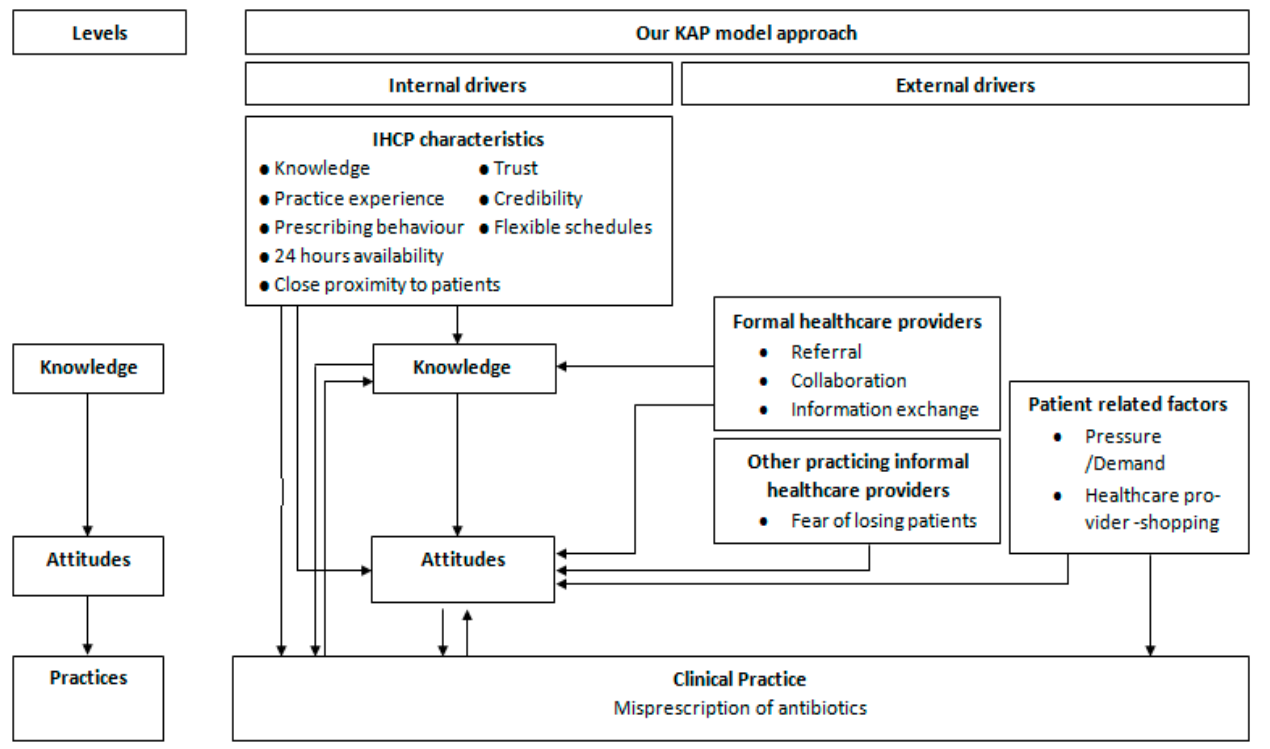
Figure 1. Overview of internal and external drivers identified, with interconnection among the driv- ers and impact on informal healthcare providers prescribing behaviour at all levels of the KAP model.